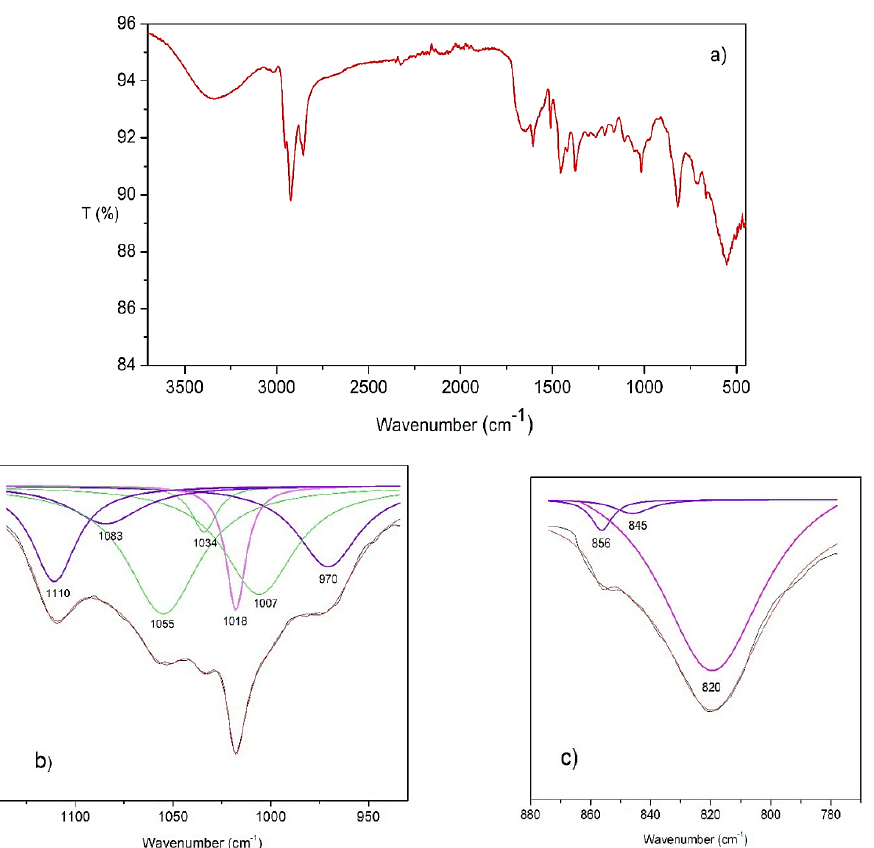
Figure 6. ( a ) FTIR spectrum of the crosslinked ionomer; ( b ) Zoom of the infrared spectrum between 930 and 1160 cm − 1 ; ( c ) between 780 and 870 cm − 1 and deconvolution of overlapped peaks. Signals of isotactic poly(1-hexene) segments (blue lines), signal of bending of quaternary ammonium groups (pink line), sum of peaks (red line), original signal (black line).